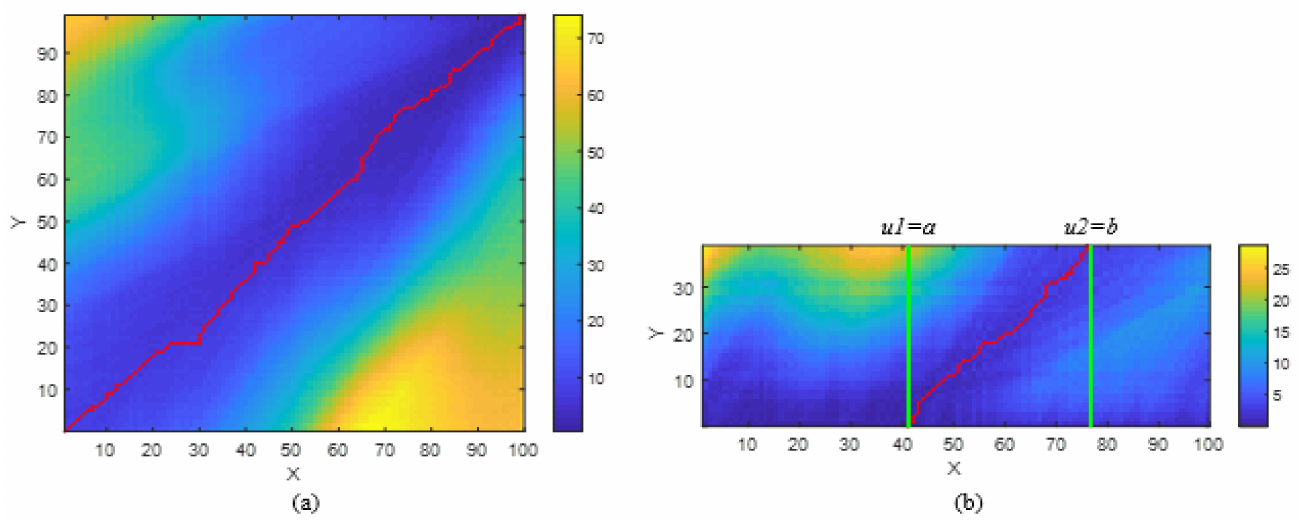
Figure 8. Accumulated cost matrix and optimal pair for ( a ) dynamic time warping and ( b ) subsequence dynamic time